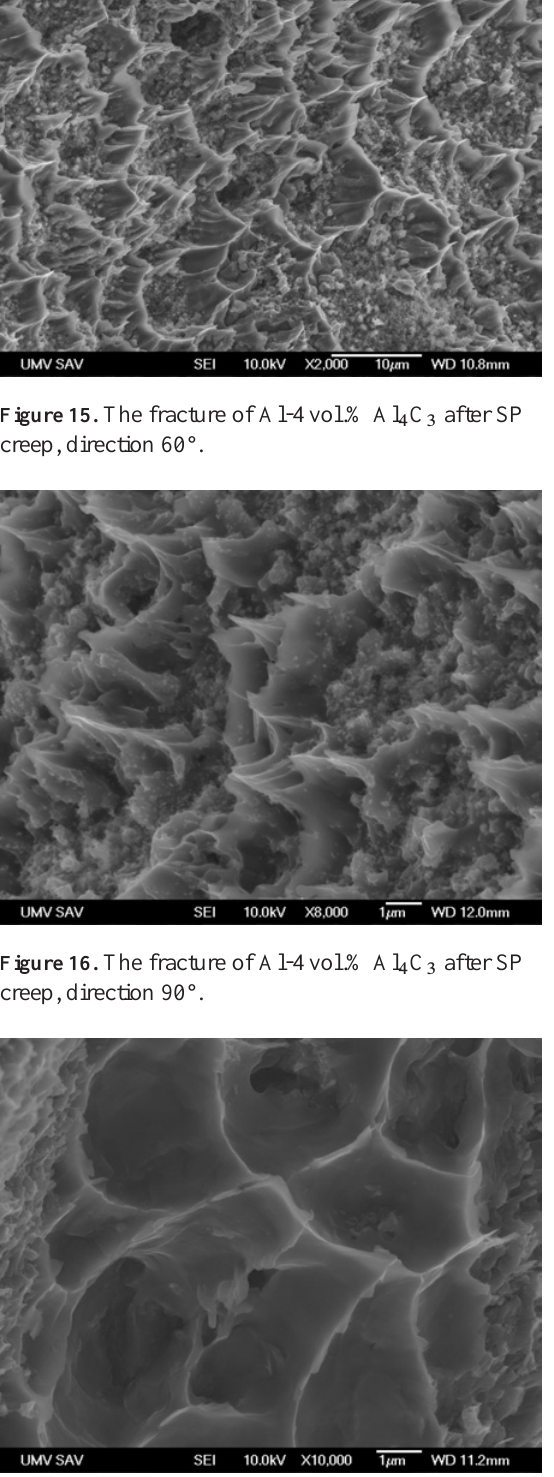
Figure 14. The fracture of Al-4 vol.% Al 4 C 3 after SP creep, direction 45°.